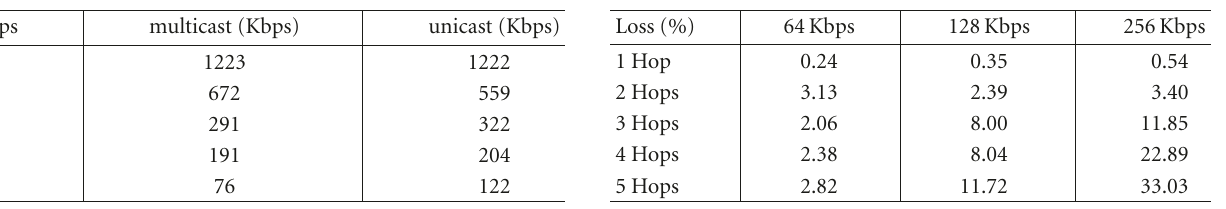
Table 4: Packet loss: multicast routing and autoconfiguration.